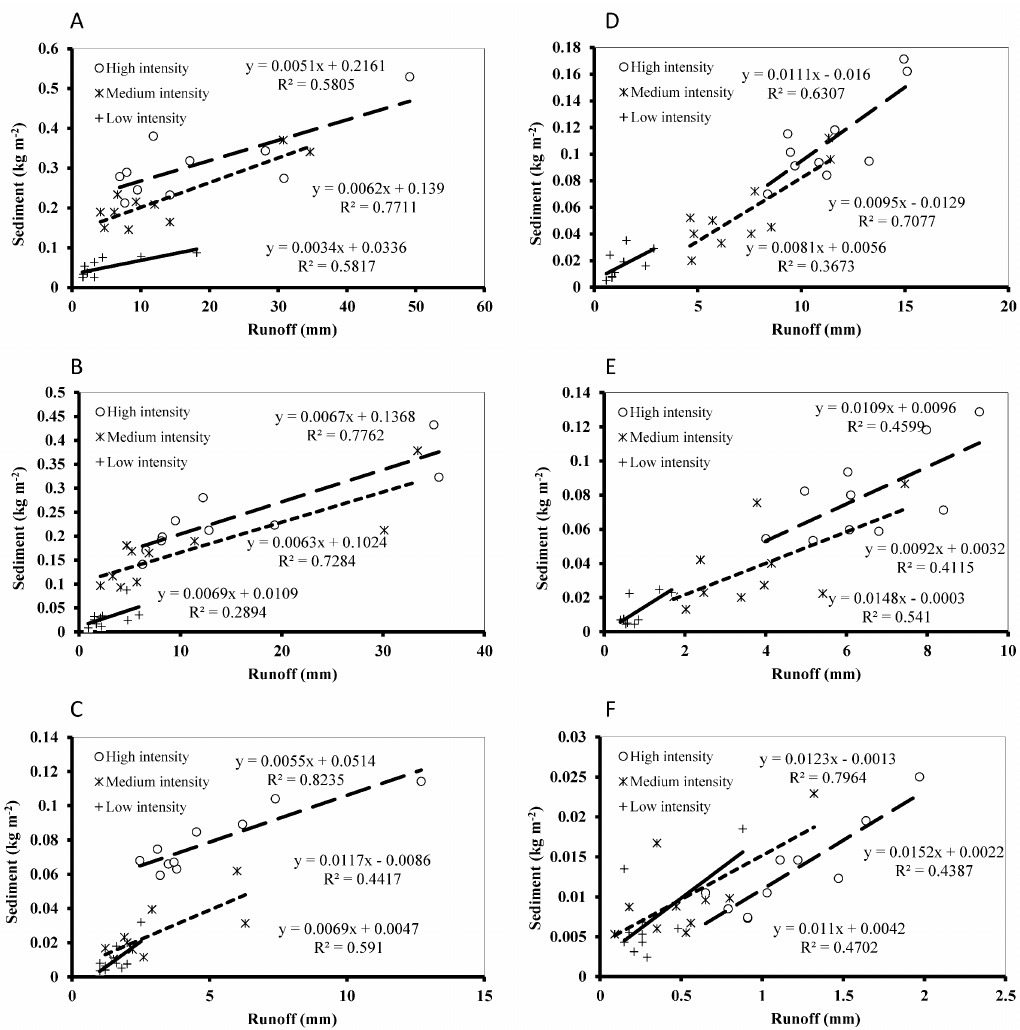
Figure 2. The relationship between runoff and sediment in the treatments during first year ( A – C ) and second year ( D – F ), and trail gradient 35% ( A , D ), 25% ( B , E ), and 15% ( C , F ). For each graph, the regression equation between responses and treatment, and the coefficient of determination ( R 2 ) are given. High, medium, and low traffic intensities are identified by long dashes, short dashes, and solid lines, respectively.